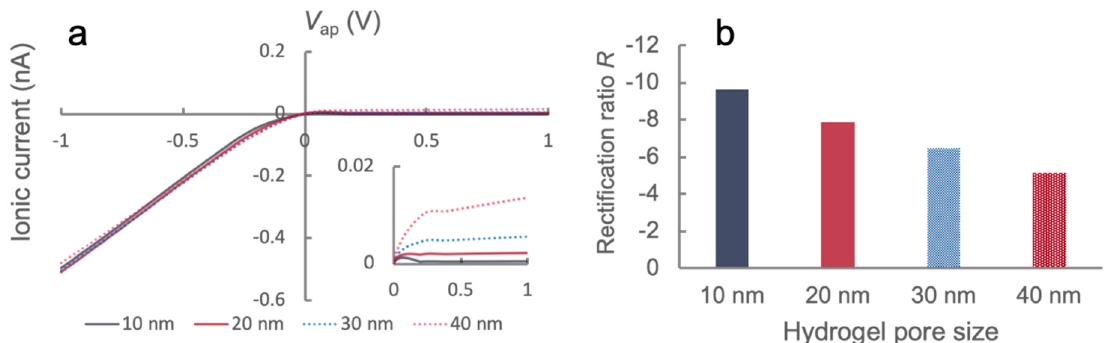
Figure 4. Simulation of the effects of hydrogel pore size on ionic transport characteristics in PHIDs: ( a ) I-V characteristics of the hydrogel junction for various pore sizes. The inset highlights the ionic currents when V ap > 0; ( b ) Rectification ratios of the hydrogel junction obtained from respective I-V curves.